Question: Summarize what this figure shows in one sentence.
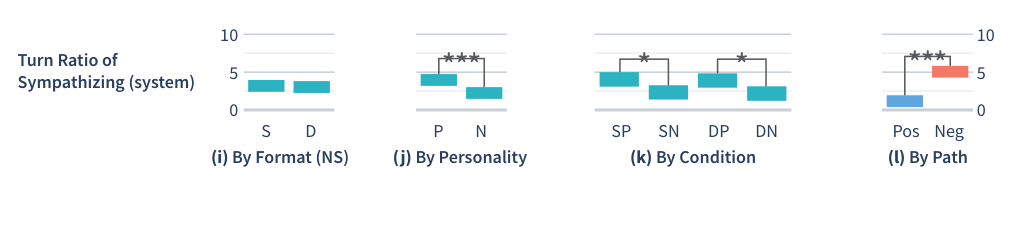
Answer: 95% confidence intervals of the chatbot turn ratios for Acknowledging (a–d), Appreciating (e–h), and Sympathizing (i–l) behaviors by information format, personality modifier, study condition (combinations of format and personality modifier), and conversation path. Variables that are not significant are marked as ‘NS.’ (Refer to Appendix A.5 for model details and statistics.)